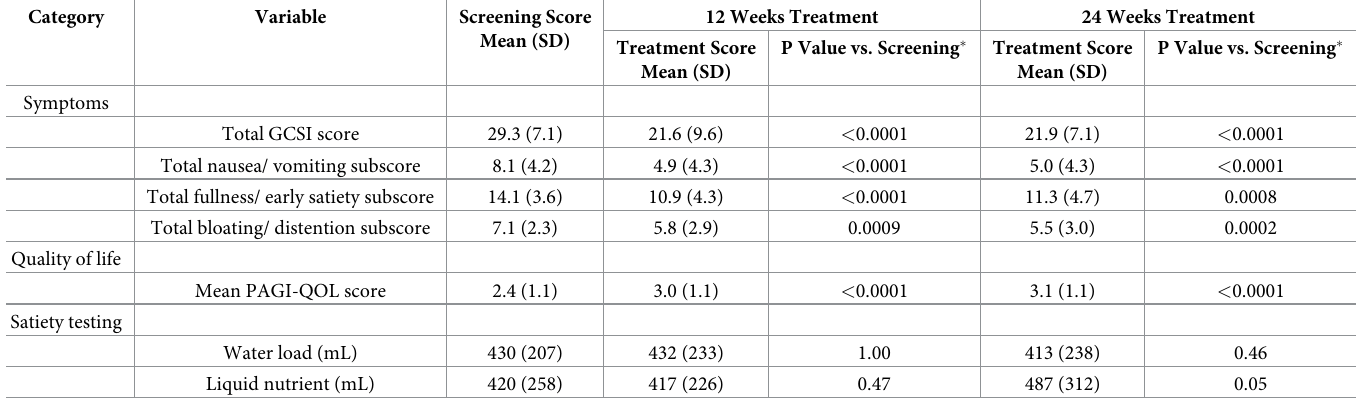
Table 6. Effect of CSII plus CGM treatment on gastroparesis symptoms, quality of life, and meal